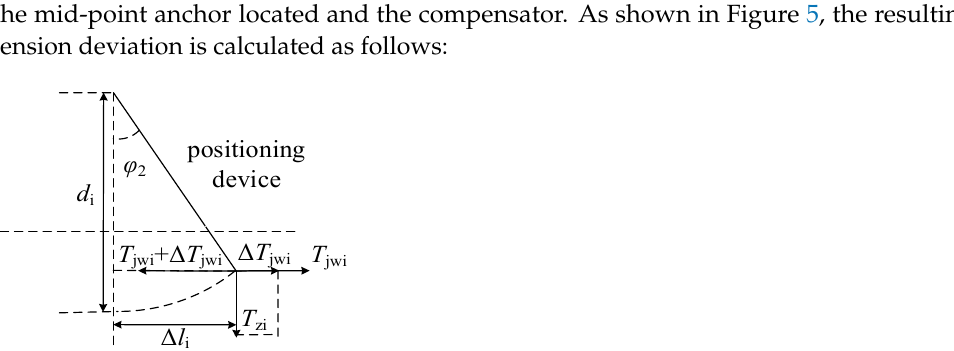
Figure 5. Analysis of tension deviation of the contact wire resulting from the offset of the positioning device.